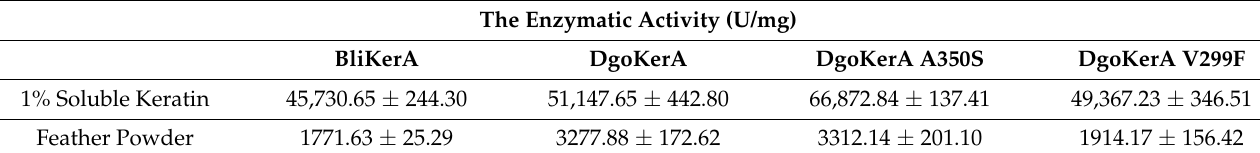
Table 2. The enzymatic activities of several keratinases on 1% soluble keratin and feather powder.